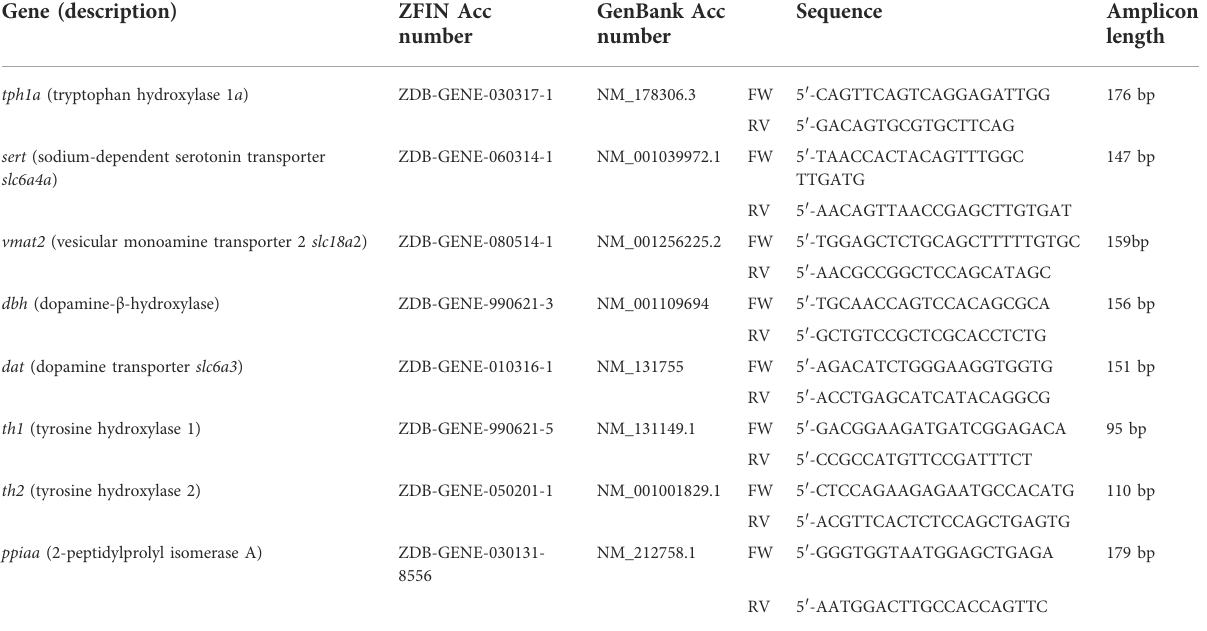
TABLE 1 List of primers used for